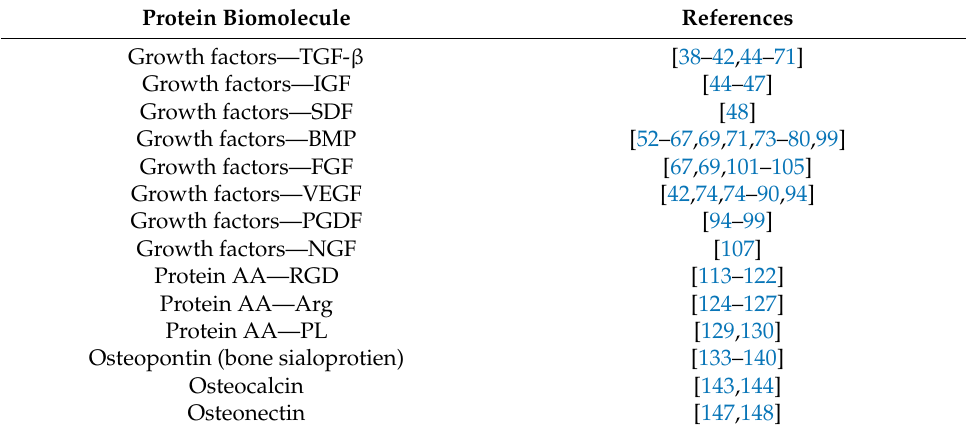
Table 1. Summary of the discussed protein biomolecule